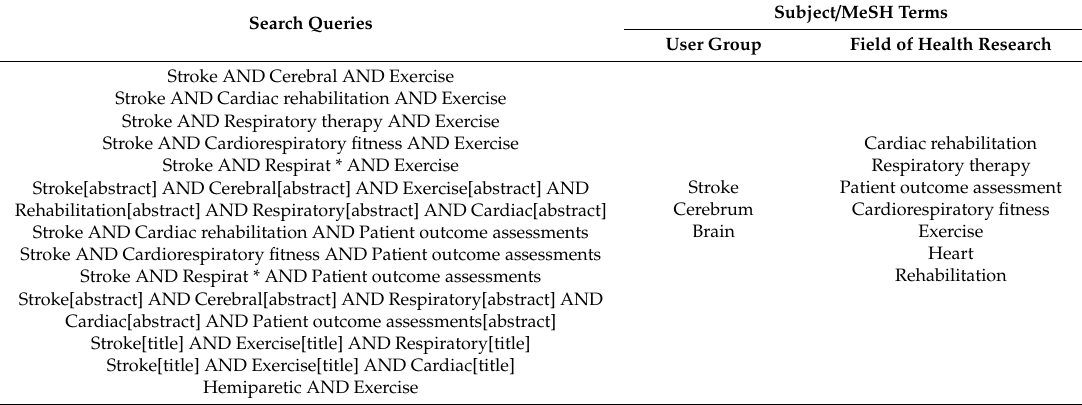
Table 1. Search strategy using Medical Subject Headings (MeSH) terms in PubMed.